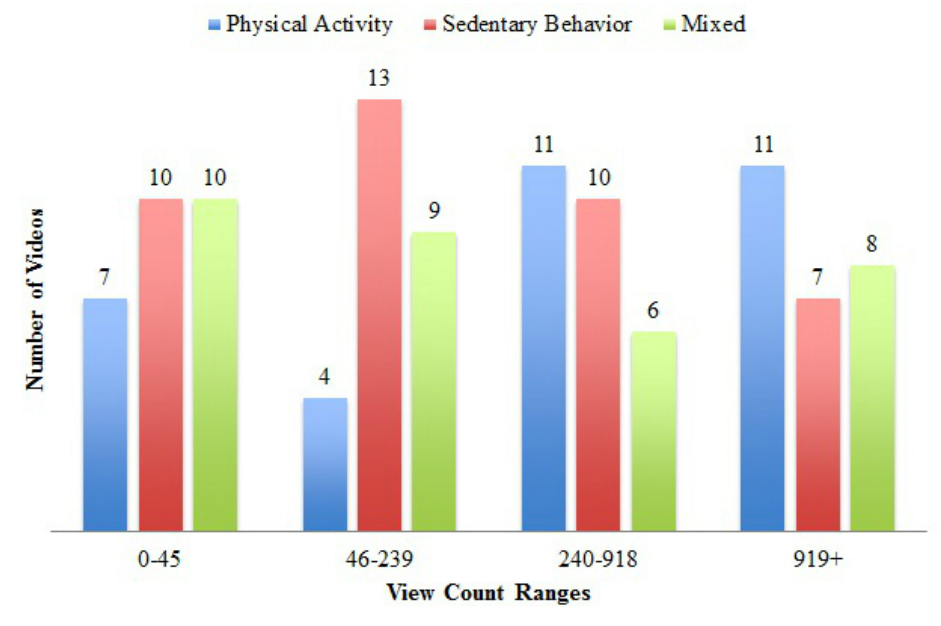
Figure 3. Activity type portrayed in videos by interquartile range of views.